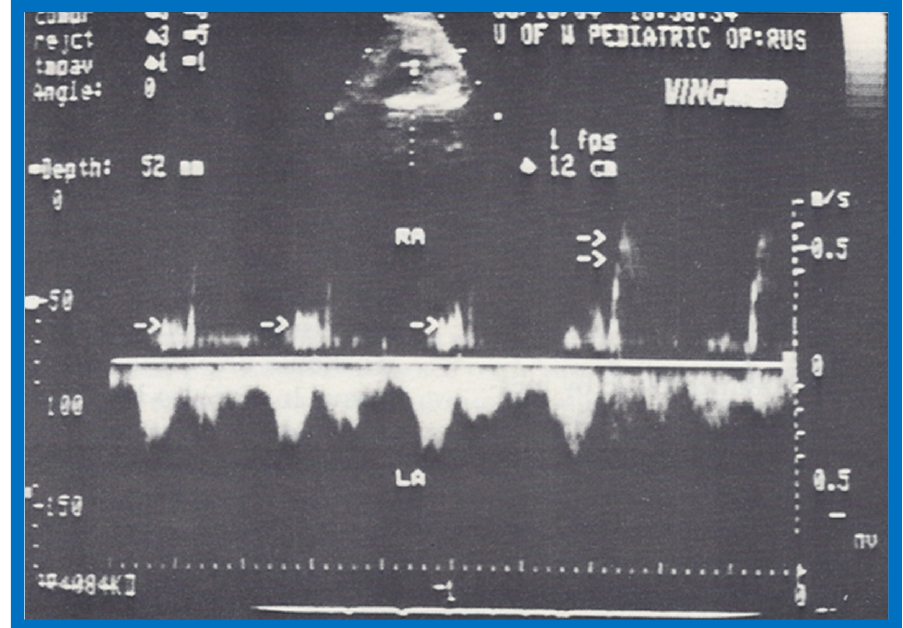
Figure 61. Pulse Doppler recording with the sample volume placed on the left atrial side of the foramen ovale (insert at the top) demonstrating transatrial flow. The majority of the flow is from the right atrium (RA) to the left atrium (LA) (bottom of the baseline). Left-to-right atrial shunt (above the baseline) is also seen, as marked by single arrows in the first three beats. Double arrows on the fourth beat shows Doppler recording of the ascending aortic flow, which serves to reference the timing of ventricle systole. Reproduced from Wilson AD, Rao P.S., Aeschlimann S. [19].